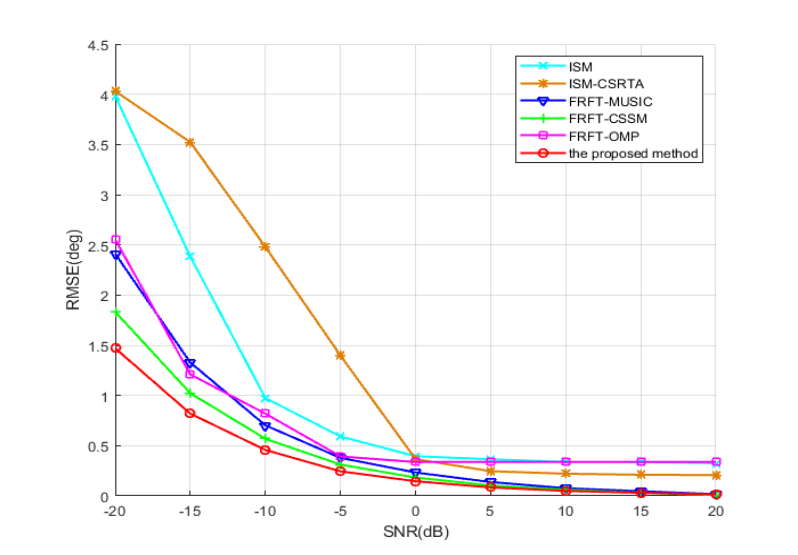
Figure 8. RMSE of the DOA estimations vs. input